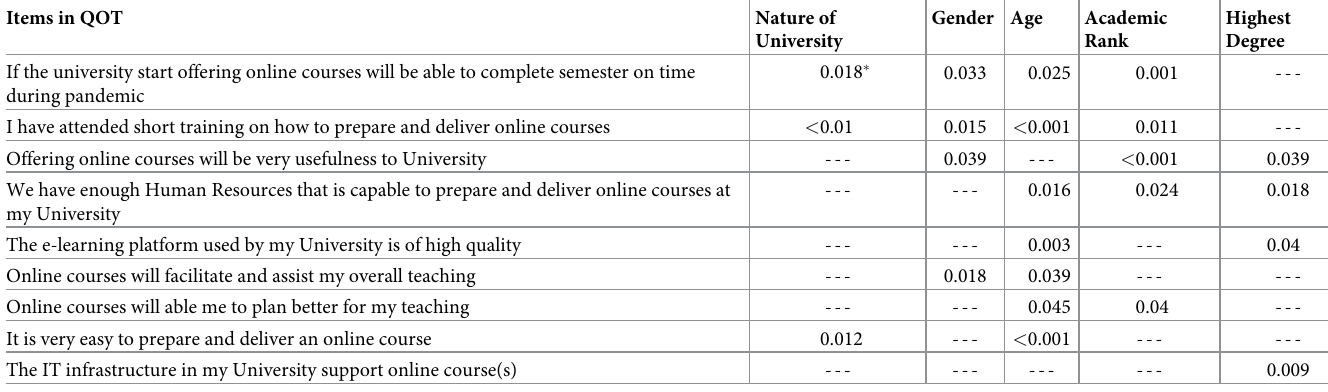
Table 5. Statistical significant association of responses and demographic characteristics of pharmacy faculty. Items in